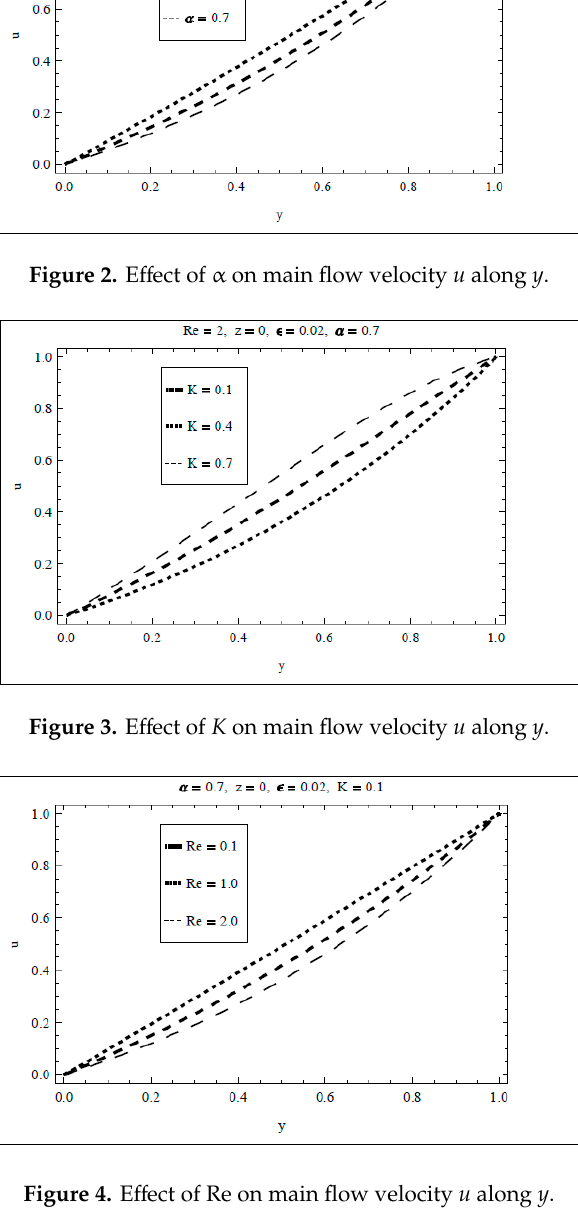
Figure 5. Effect of α on cross-flow velocity v along y .